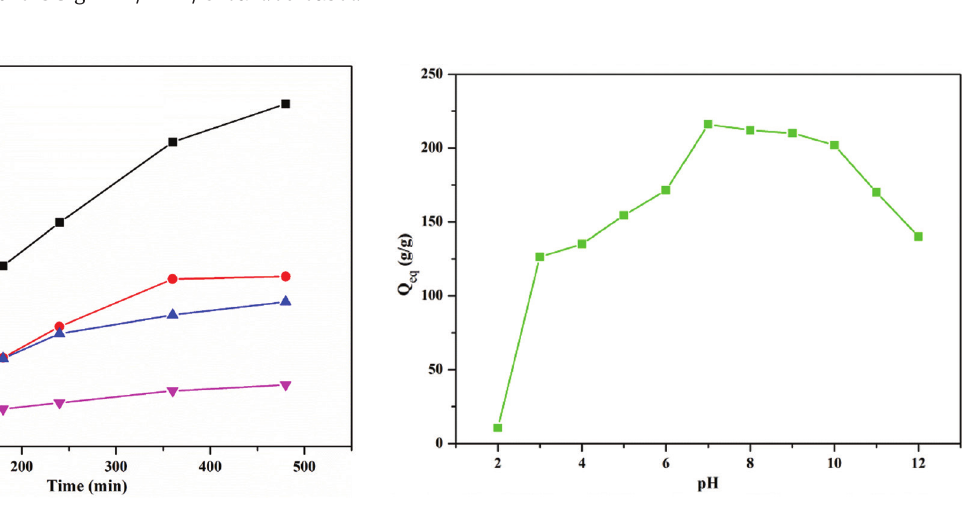
Figure 10: Effect of pH on water absorbency of